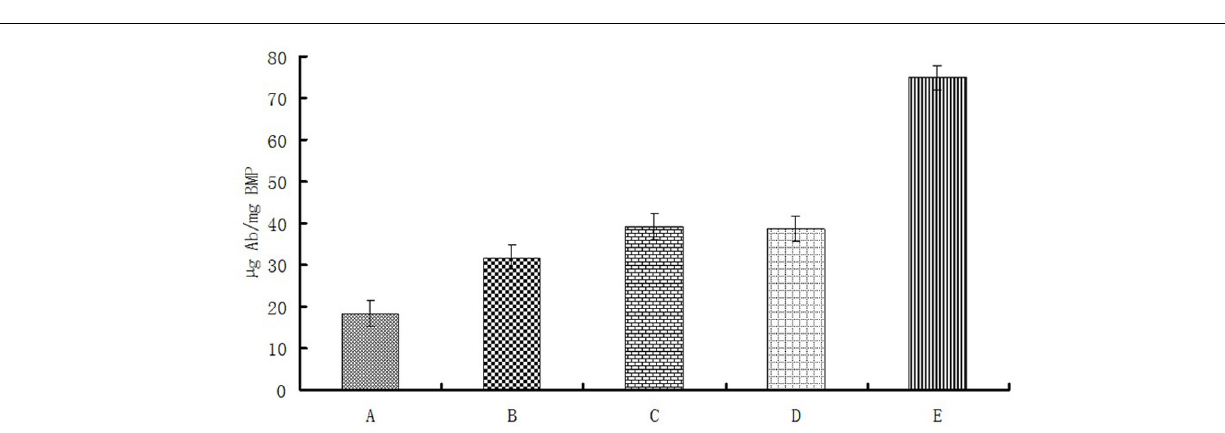
FIGURE 5 | Magnetosome-Ab linkage rates for different linkage methods under optimal conditions as in Figure 4. (A), Nonspecific adsorption of BMP-WT on Ab; (B), BS 3 linkage of BMP-WT to Ab; (C), self-assembly of BMP-CA and Ab; (D), self-assembly of BMP-FA and Ab; (E) self-assembly of (cid:2) F-BMP-FA and Ab.